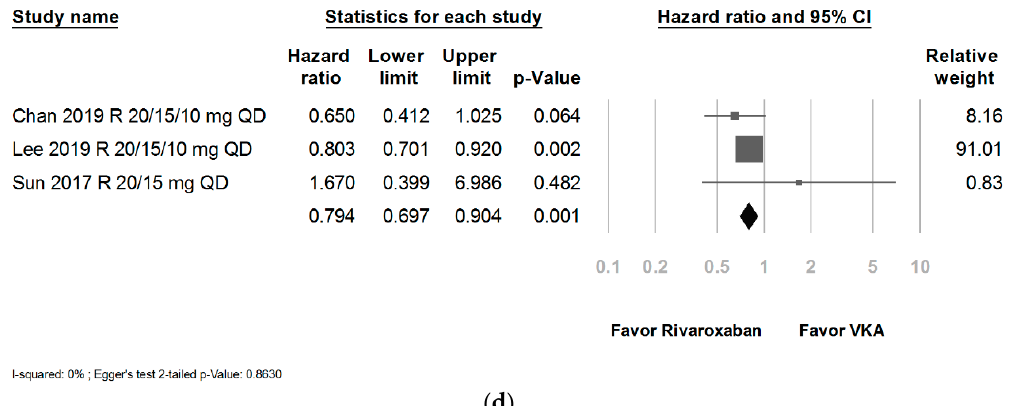
Figure 4. ( a ) Forrest plot of comparison: the subgroup of apixaban versus vitamin K antagonists. ( b ) Forrest plot of comparison: the subgroup of edoxaban versus vitamin K antagonists. ( c ) Forrest plot of comparison: the subgroup of dabigatran versus vitamin K antagonists. ( d ) Forrest plot of comparison: the subgroup of rivaroxaban versus vitamin K antagonists.